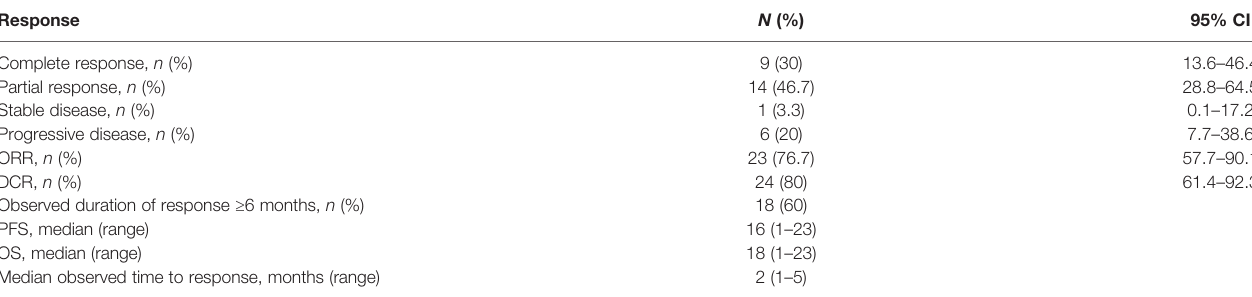
TABLE 2 | Assessment of tumor response (30